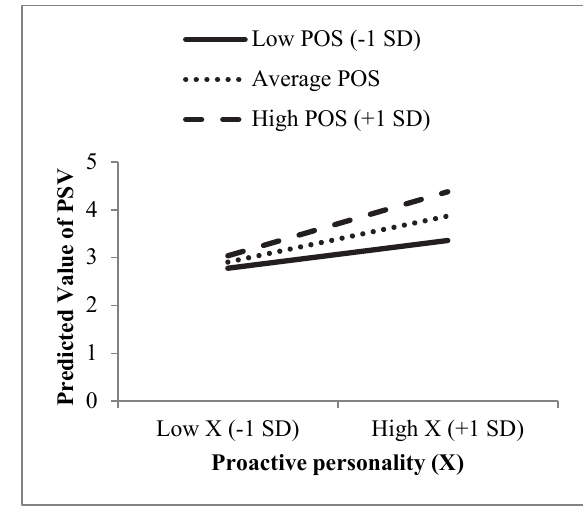
Fig. 3. POS as a moderator in the relationship between PP and